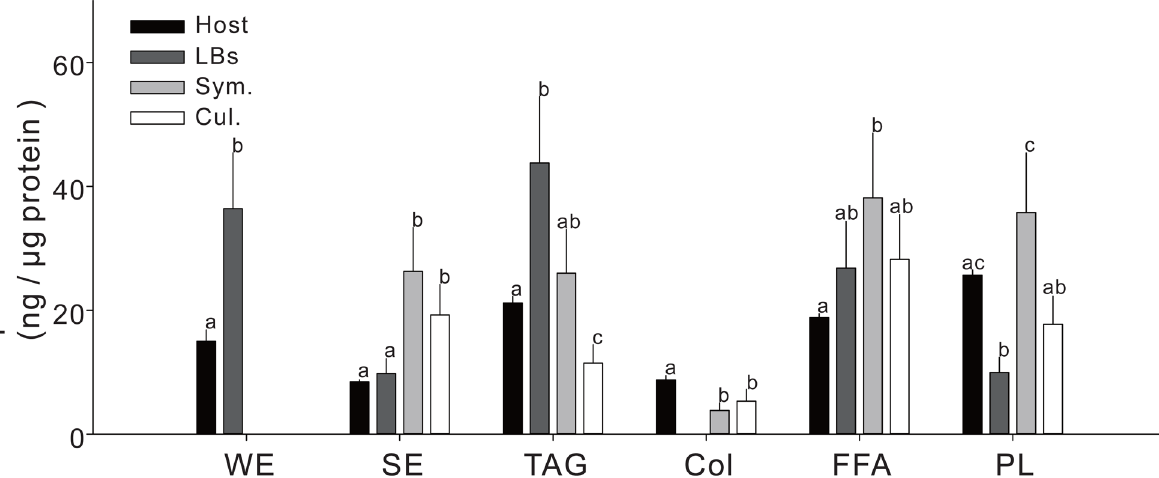
Fig 2. Concentrations of lipids in coral host gastrodermal cells ( “ host, ” black columns), lipid bodies ( “ LBs ” , dark gray columns), in hospite Symbiodinium ( “ Sym. ” , light gray columns), and cultured Symbiodinium ( “ Cul. ” , white columns). The full names of the individual lipid species can be found in the text. Values (mean ± SD, n = 4) with different superscripts within a lipid species signify significant differences in concentrations between the four fractions (Mann Whitney post-hoc U tests, p < 0.05). When a column is not depicted, the respective lipid was not